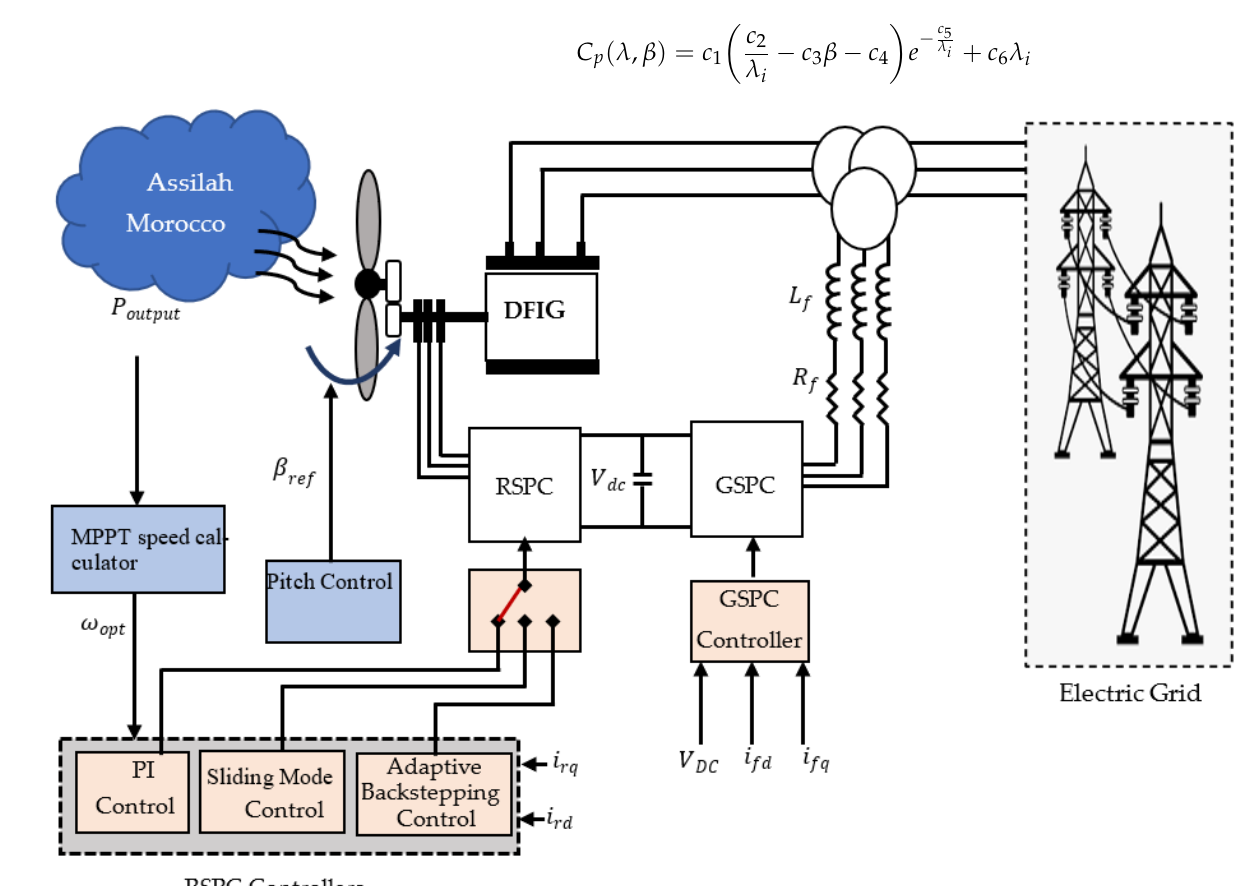
Figure 2. General overview of DFIG linked to the grid.